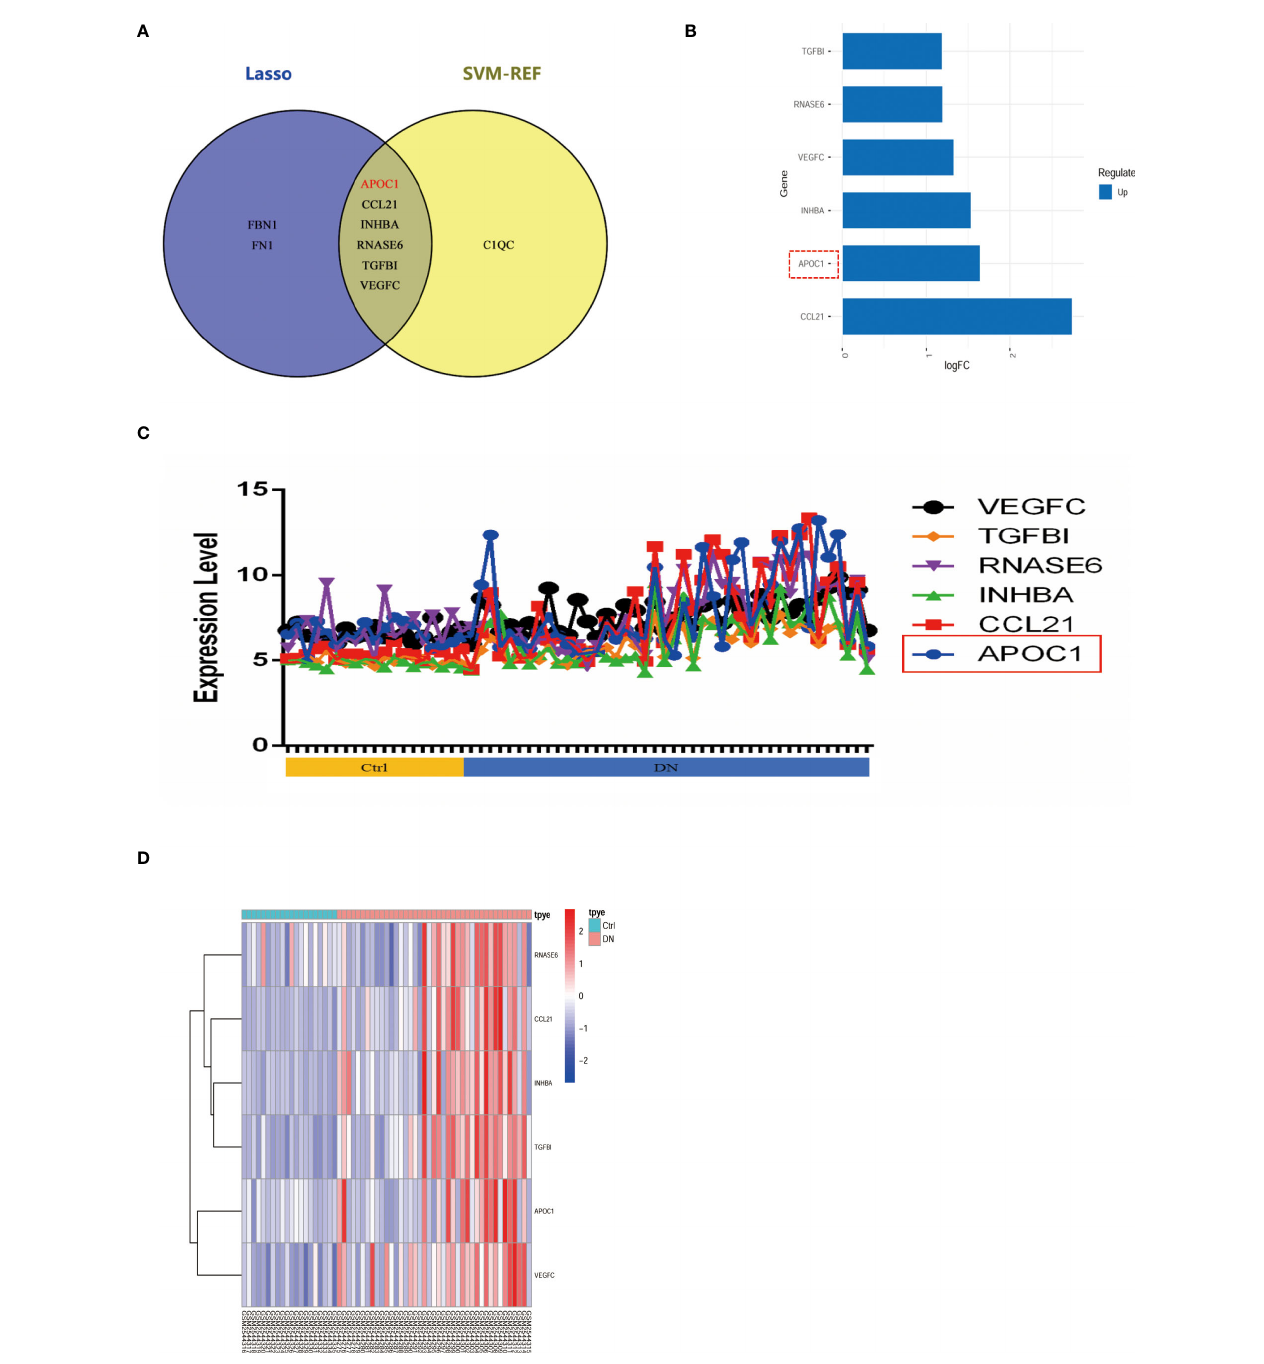
FIGURE 5 6 potential secretory genes were obtained in GSE96804 by machine algorithms. (A) The intersection of genes obtained by the two machine algorithms (SVM-RFE and Lasso algorithms). (B) Deviation plots showed the expression of six secreted genes in DN. (C) Folding line graph illustrates the different expression of 6 hub genes. (D) Heat plots revealed elevated expression of six secreted genes in